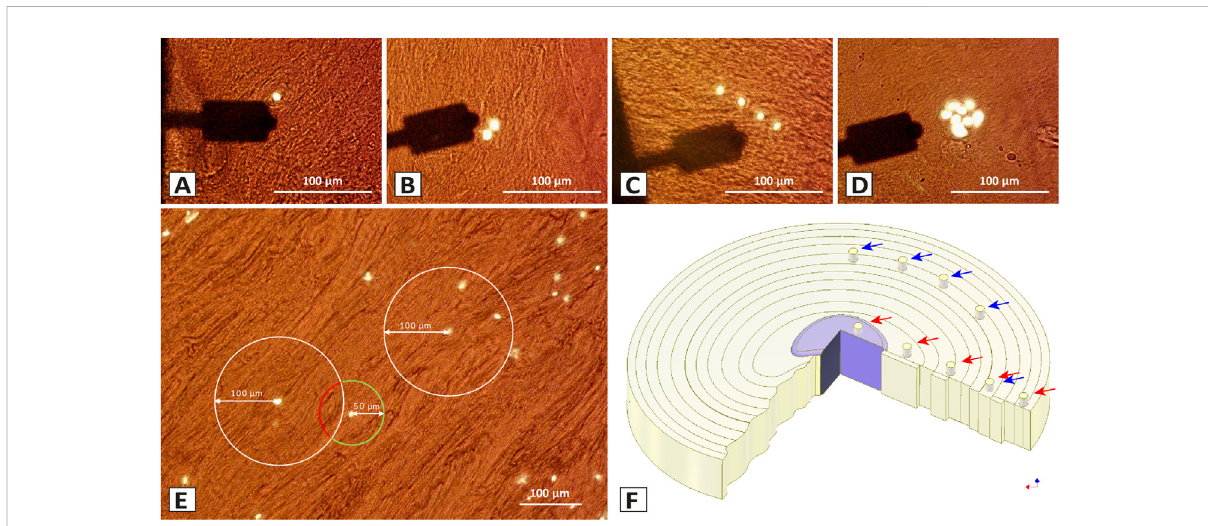
FIGURE 1 DifferentspatialchondrocytepatternsintheIVD,selectionofthemeasurementsites,andsampledareasinthebovineIVDfortheECMandPCM using Atomic Force Microscopy (AFM). (A – D) Bright fi eld histological section of the IVD (35 µm) showing the arm of the cantilever (black) and the chondrocytes in their ECM (brown). The different spatial chondrocyte patterns analysed were single cells (SC) (A) , pairs (P) (B) , string-formations (SF) (C) , and clusters (Cl) (D) . The PCM measurement site was chosen directly over the nuclei (white). (E) The ECM measurement was performed at 50 µm away from the nuclei of the pattern of interest (green circle) and at the same time being at least 100 µm apart from all other patterns (determined by the white circle). (F) To evaluate the variability of the data with our measurement technique, tissue from fi ve similar but independent locations in the central anulus fi brosus in one bovine IVD were analysed (blue arrows). To investigate the changes in ECM and PCM values and their ratio depending on their location in the disc, fi ve different tissue origins (red arrows) were selected on each of fi ve different bovine discs going from thecentralnucleuspulposus(CNP),totheinnerintermediatezone(IIZ),theouterintermediatezone(OIZ),theinneranulus fi brosus(IAF),totheouter anulus fi brosus (OAF).